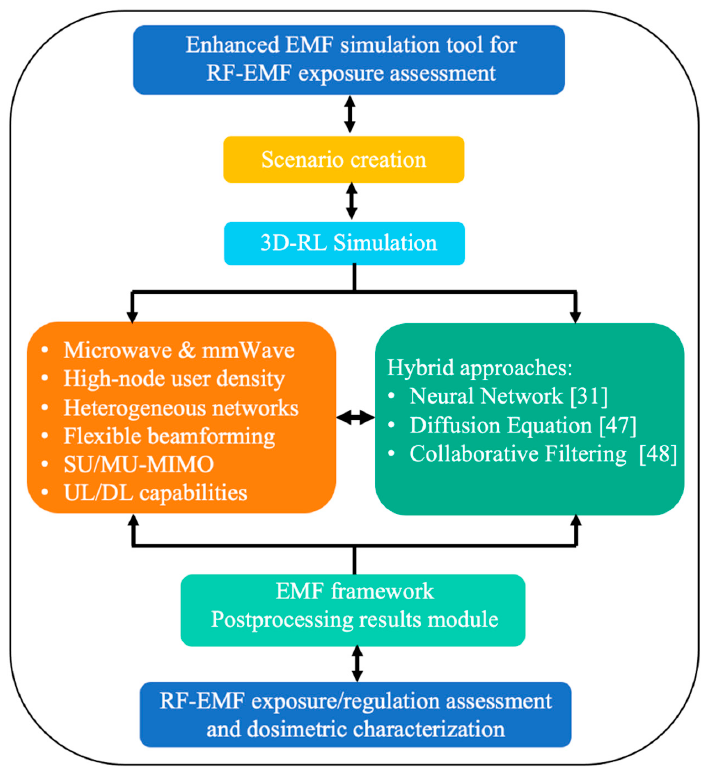
Figure 2. Flowchart of the enhanced RF-EMF exposure and regulation assessment simulation tool.